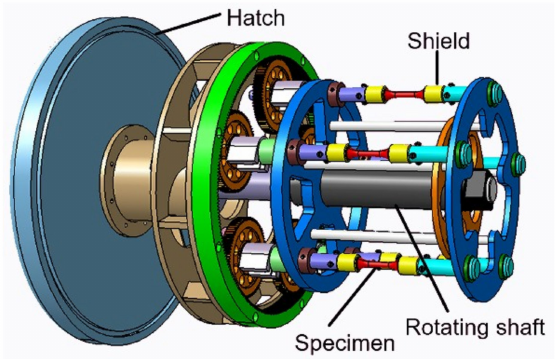
Figure 3. The rotating bracket for homogeneous coating